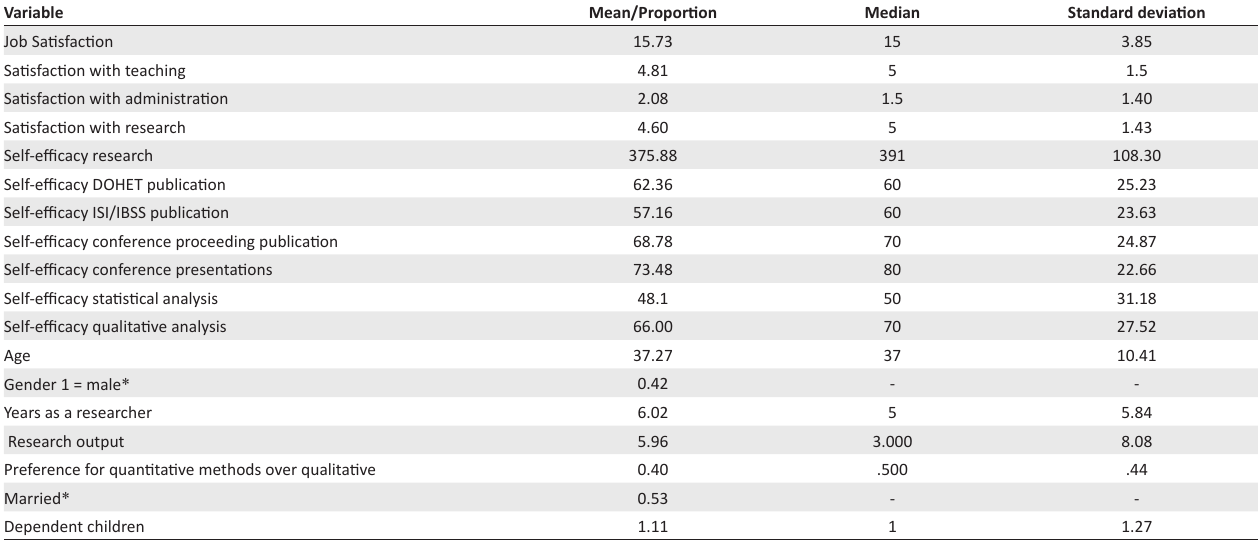
TABLE 1: Descriptive statistics: Mr/Ms designation.